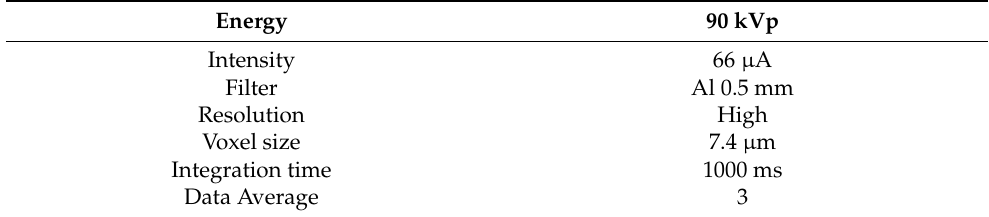
Table 1. Parameters used for scanning.